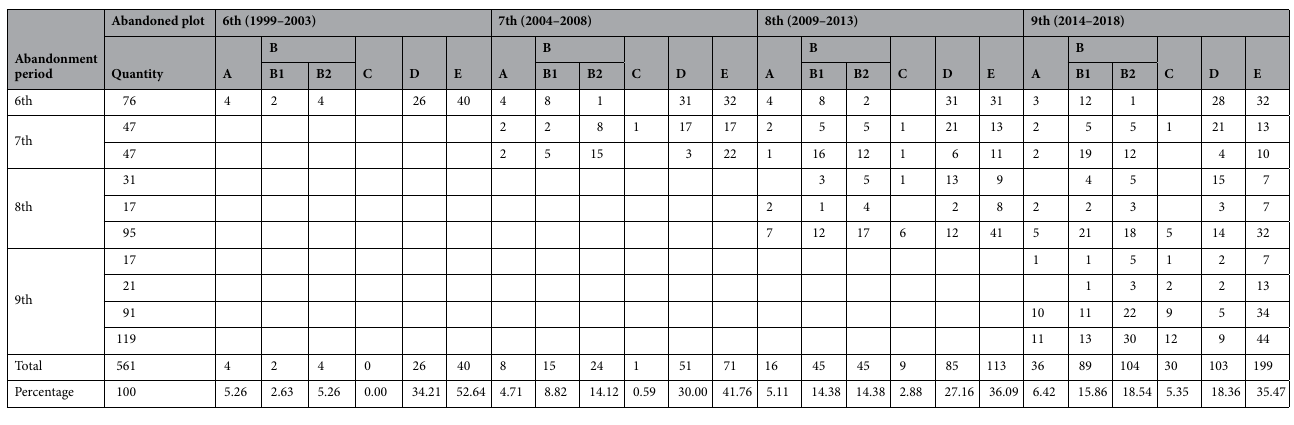
Table 9. Temporal change of tree species planted in sample plots. A conifers, B broad-leaf trees, B1 eucalyptus, B2 Broad-leaf trees other than eucalyptus, C mixed forest, D economic tree species, E not used for plantation.